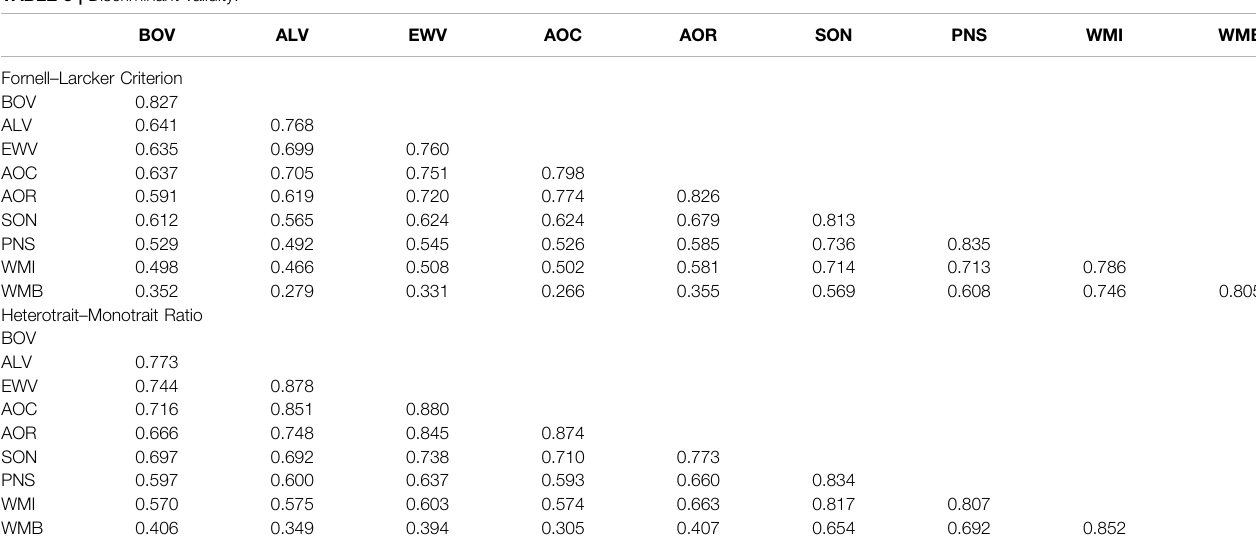
TABLE 3 | Discriminant